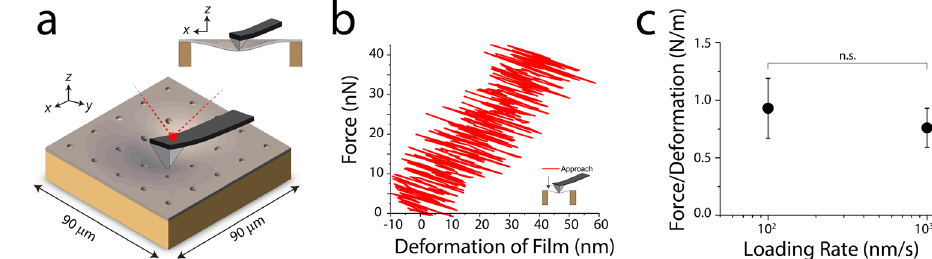
Fig.3|Mechanicalcharacterizationofcarbon fi lmcellsubstrate.a Schematicof carbon square of EM grid being loadedin the center by the AFMprobe. b Example of a single distance/force curve from loading one of the grid squares at a loading rate of 100nm/s (red-approach). c The slopes of force/deformation curves (determined by a total least square regression) were used to calculate the spring